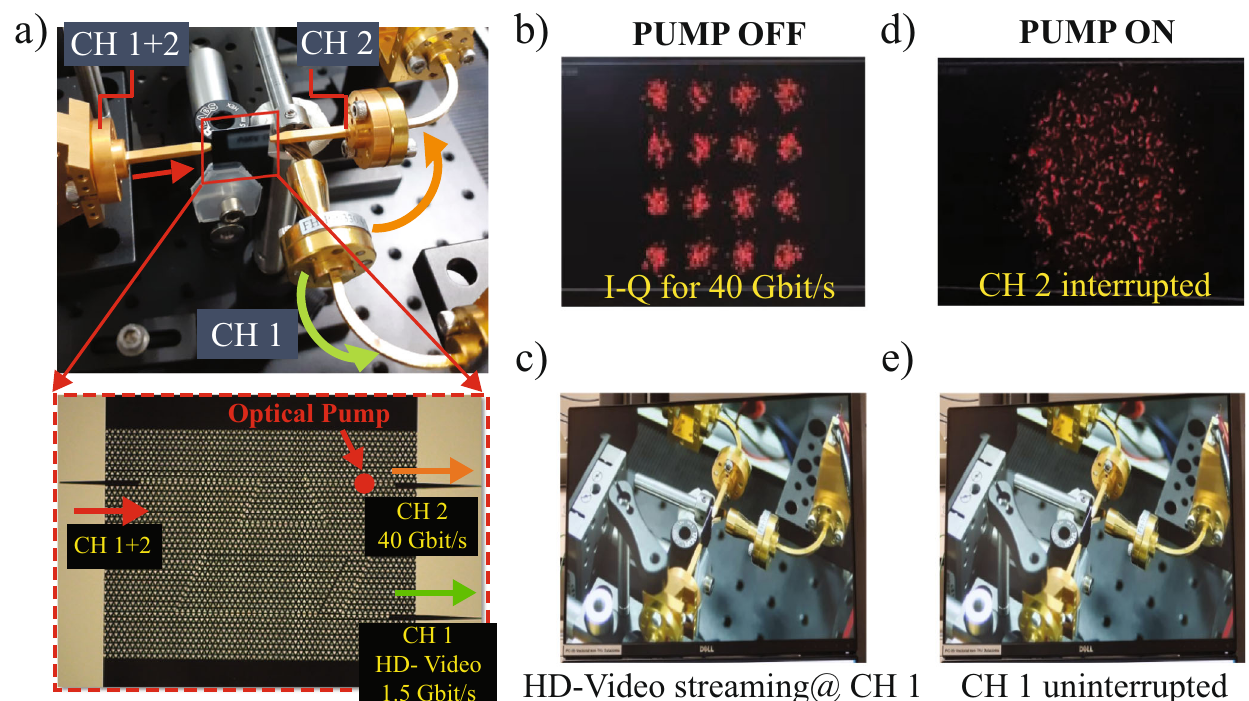
Fig. 4 | HD-video streaming and perfect channel isolation in photoactive topological demultiplexer. a THz communication experimental setup. Here two signalsatdifferentcarrierfrequencies(331.6GHzand344GHz)wereinjectedatthe input port (highlighted as CH 1+2) of the Si-VPC chip. Due to the limited spacing between CH 1 and CH 2 couplers in the Si-VPC chip (shown in inset), we used a parabolic mirror to redirect the signal from CH 1 and collected it by using a horn antenna ( a ). Insetshows the opticalimage offabricated Si-VPC chipwith one input and two output ports. The redarrow highlights the input channel(CH1+2),which further demultiplexed into two channels: CH 1 (green arrow) and CH 2 (orange arrow). b , d I – Qintensityconstellationdiagramrecordedatchannel2(CH2;carrier frequency 344GHz) of Si-VPC chip for PUMP OFF and ON case,